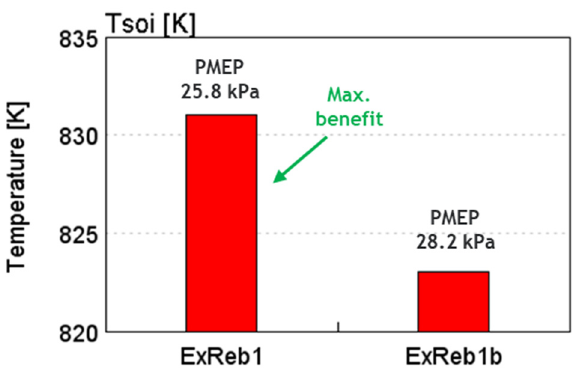
Figure 19. Comparison of the Tsoi and the PMEP trends between the ExReb1 and ExReb1b profiles.